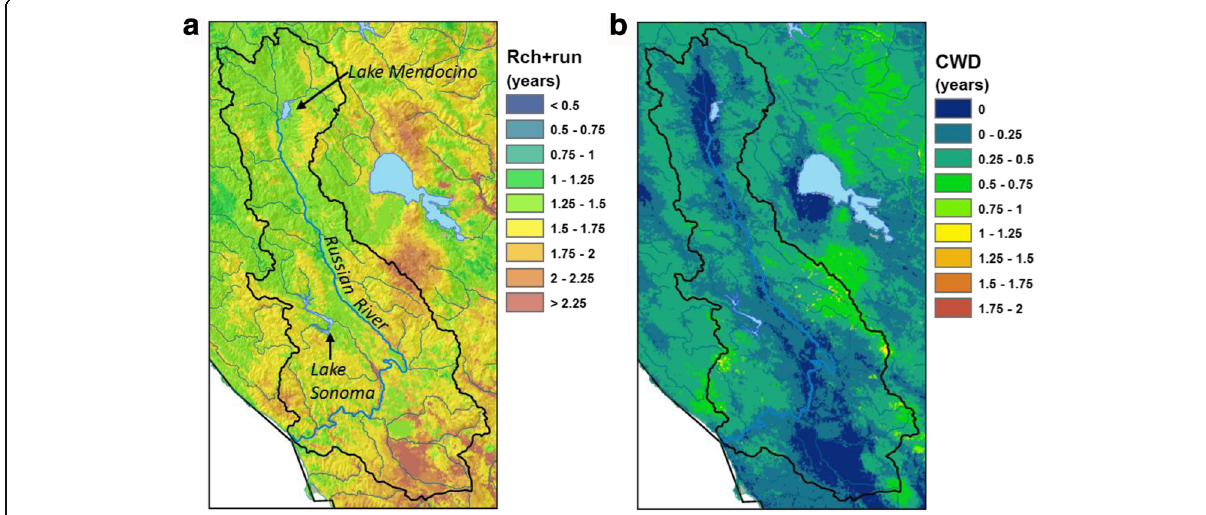
Fig. 4 Calculations of Russian River watershed drought metrics of a water supply (recharge plus runoff) for years of missing water supply accumulated for drought water years 2012 – 2016 and b landscape drought (climatic water deficit) for years of accumulated landscape stress for drought water years 2012 –